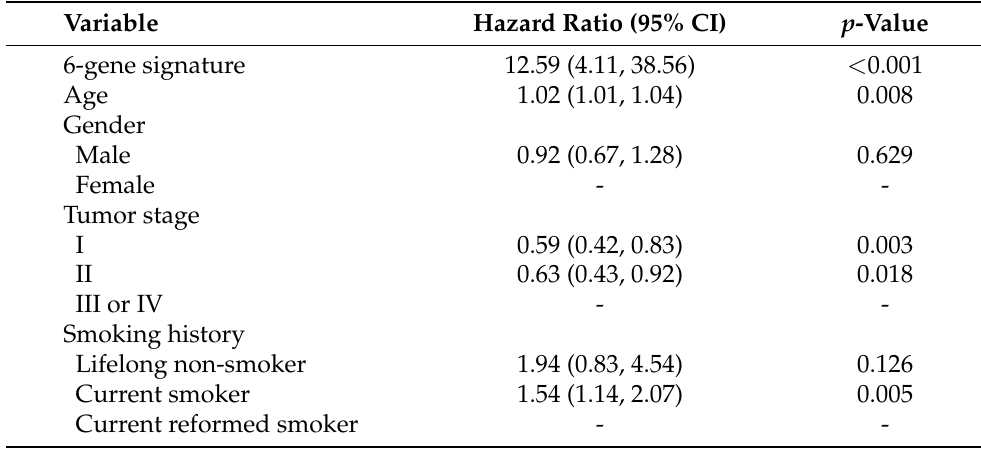
Table 3. Multivariable Cox regression analysis of the risk of death against the 6-gene signature identified by ESIS+PenCox and other clinical covariates. CI denotes confidence